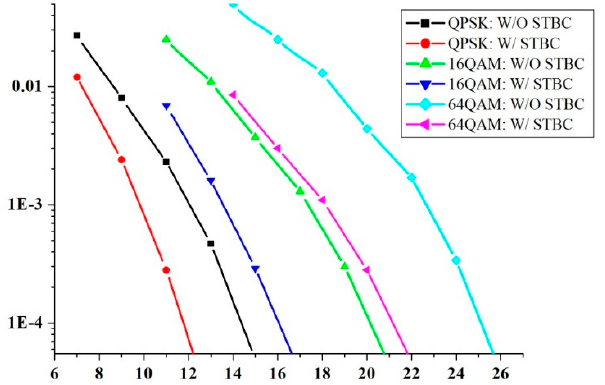
Figure 19. The summary of BER vs. OSNR for various modulation formats with or without using STBC-RLS compensation [29].